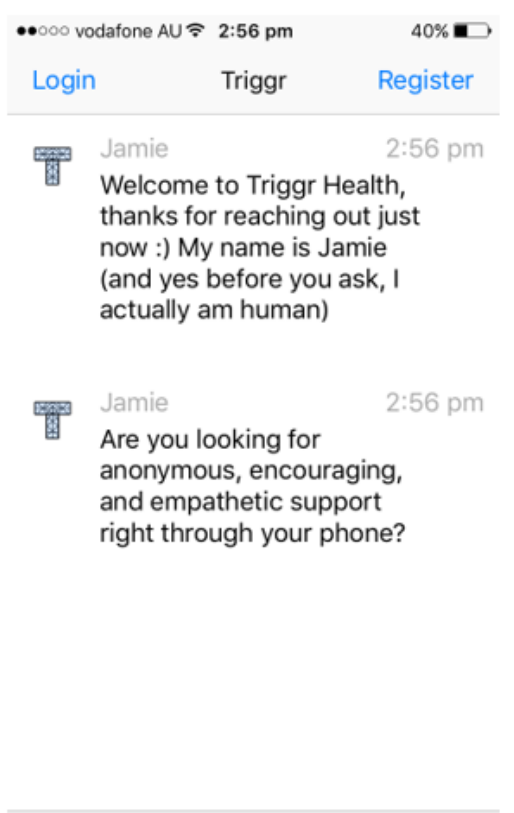
Figure 3. Screenshots of the Triggr Health App. (Source: Triggr Health - Support for Reducing Drinking/Using iPhone App Version 2.19.4. Developer: Triggr LLC. Licensed under fair